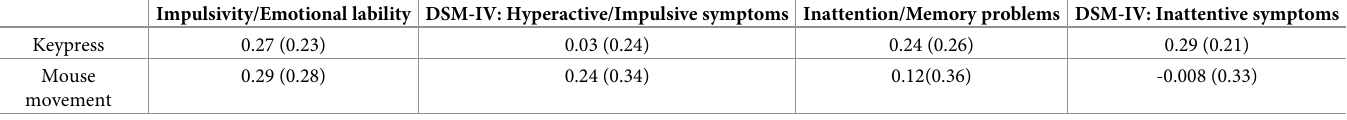
Values outside the parentheses illustrate the median values of ρ . Values inside the parentheses illustrate the median absolute deviations of ρ .